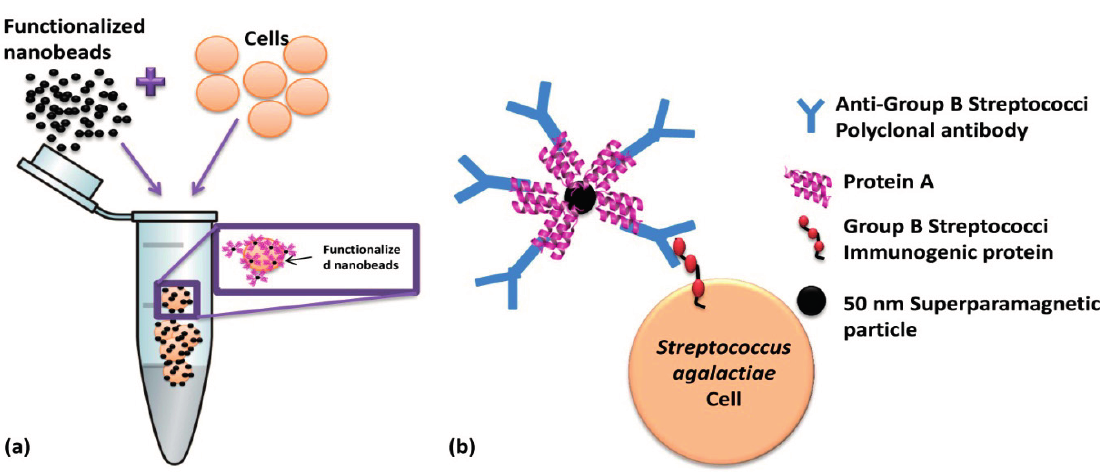
Figure 4. Schematics of immuno-magnetic functionalization of cells ( a ) Incubation of functionalized beads with Streptococcus agalactiae cells and ( b ) biological affinities between beads protein A, polyclonal IgG antibodies and bacterial cell wall